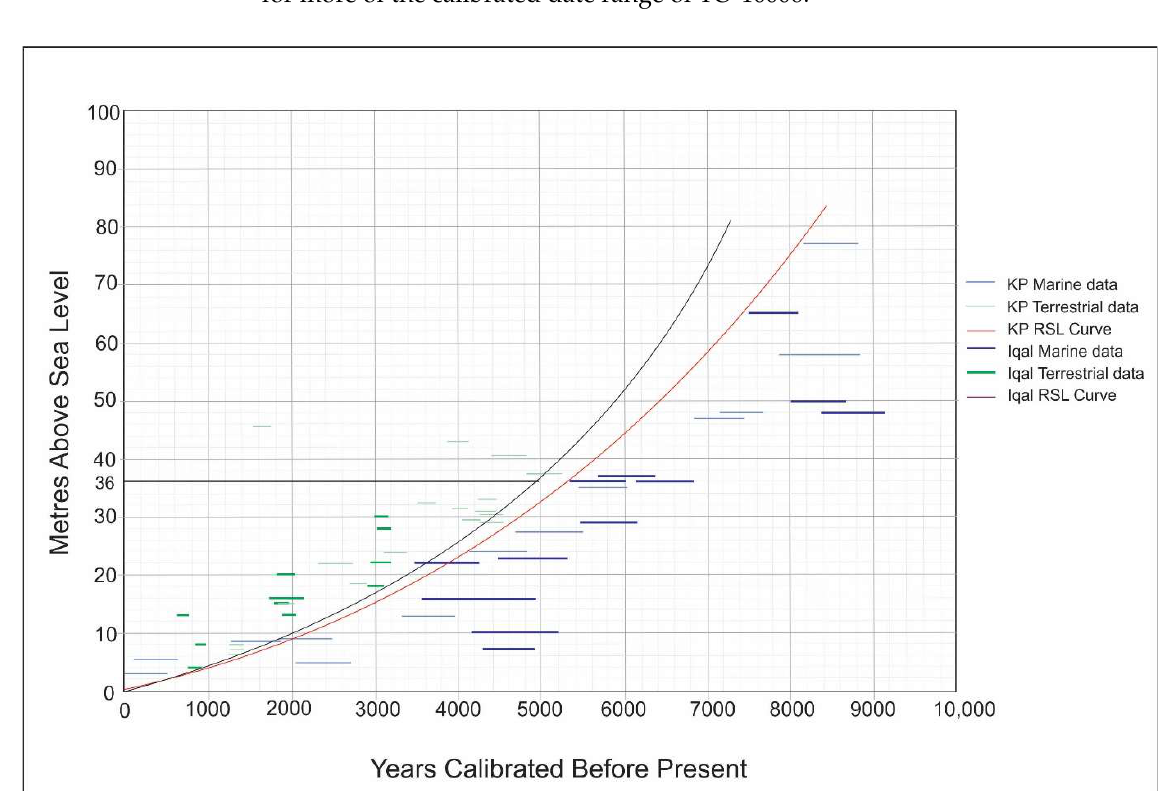
1 Indicates a potentially anomalous date. 2 Kent Peninsula dates from Paleoeskimo Demography and Sea-Level History, Kent Peninsula and King William Island, Central Northwest Passage, Arctic Canada [44]. The curve for this area is typical of many other relative sea level curves for the Cana- dian Arctic (Figure 3). The curve indicates an initial rapid rebound which slows after between 6000 and 5000 cal B.P. [34,49,81–83]. The nearest established curve at Kent Penin- sula is the most similar [44]. This reinforces confidence in the accuracy of the Iqaluktuuq curve. The main difference is the Iqaluktuuq curve is slightly steeper in order to account for more of the calibrated date range of TO-10006.